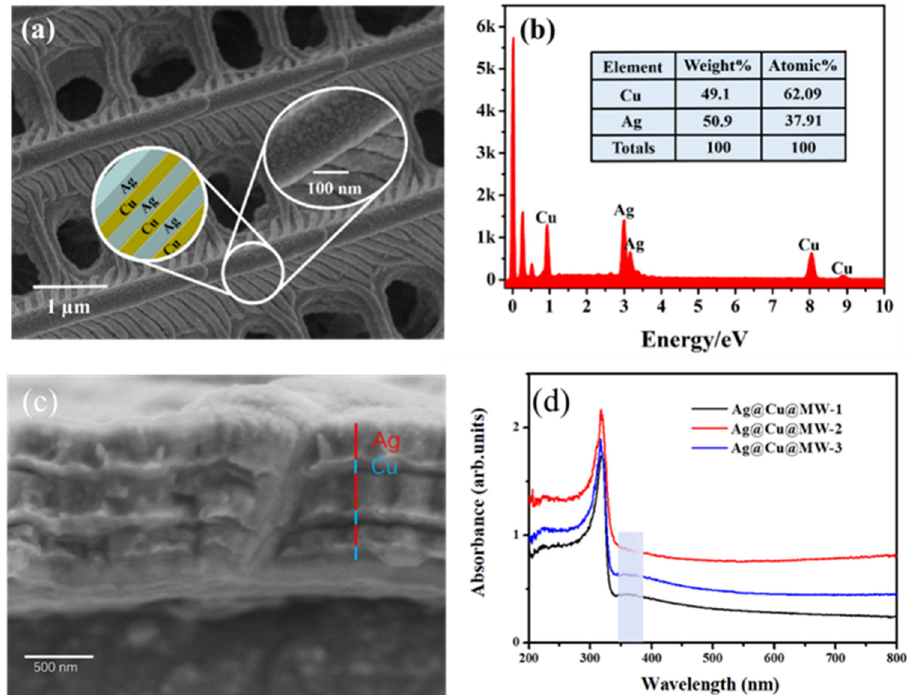
Figure 4. ( a ) Top view FE ‐ SEM image of the Ag@Cu@MW ‐ 3 substrate. ( b ) EDS graph of the